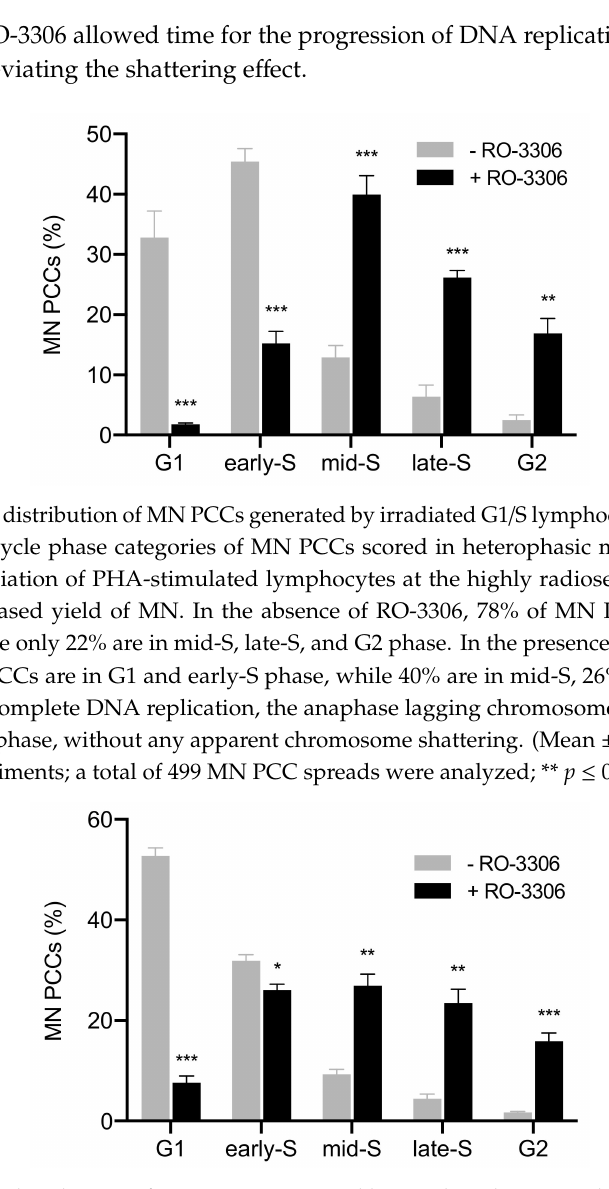
Figure 8. Cell cycle distribution of MN PCCs generated by irradiated mitotic Chinese hamster ovary (CHO) cells. Frequencies in five di ff erent cell cycle phase categories of MN PCCs scored in heterophasic micronucleated cells, generated by irradiation of CHO mitotic cells with 3 Gy γ -rays. In the absence of RO-3306, 85% of MN PCCs are in G1 and early-S phase, and only 15% are in mid-S, late-S, and G2 phase. In the presence of RO-3306 for 12 h, 33% are in G1 and early-S phase, while 27% of MN PCCs are in mid-S, 24% in late-S, and 16% in G2 phase. The presence of RO-3306 in micronucleated cells e ff ectively delayed the main nuclei to proceed to mitosis, allowing time for the progression of DNA replication in chromosomes entrapped in MN. (Mean ± SEM based on four independent experiments; a total of 958 MN PCC spreads were analyzed; * p ≤ 0.05, ** p ≤ 0.01, *** p ≤